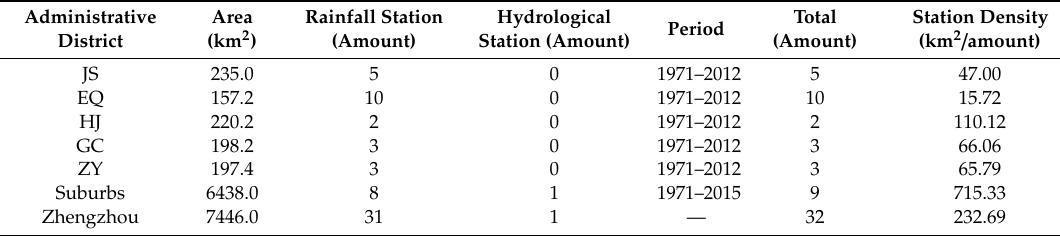
Table 1. Station Information Distribution